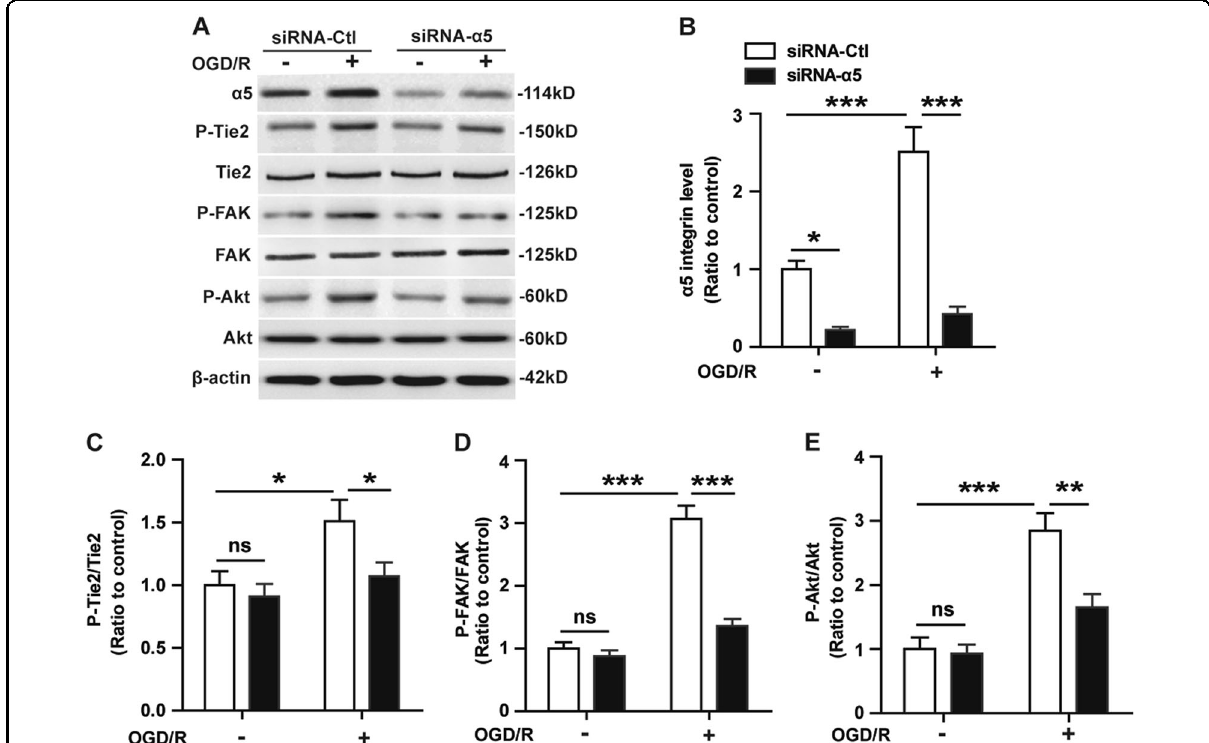
Fig. 3 Knockdown of α 5 integrin attenuates Tie2 activation in BECs induced by OGD/R. BECs were transfected with the negative control siRNA (siRNA-Ctl) or α 5 integrin-speci fi c siRNA (siRNA- α 5) for 48 h and then subjected to either 4 h of OGD followed by 48 h of restoration or NO-OGD/R at 37 °C. a Cell lysate protein levels were analyzed by western blotting using antibodies speci fi c to integrin α 5 and total or phosphorylated forms of Tie2, FAK, and Akt. b – e . Bar graphs show the quantitative analyses of western blots as ratios of integrin α 5/ β -actin ( b ), phosphorylated Tie2/total Tie2 ( c ), phosphorylated FAK/total FAK ( d ), and phosphorylated Akt/total Akt ( e ). The NO-OGD/R siRNA-Ctl-treated cells served as the control. Data represent the mean ± SEM and were analyzed by two-way ANOVA ( n = 5 ). Note that OGD/R signi fi cantly increased the levels of Tie2, FAK, and Akt phosphorylation on siRNA-Ctl-treated BECs relative to the NO-OGD/R siRNA-Ctl-treated controls, but this effect was signi fi cantly reduced by diminishing the levels of integrin α 5 in the BECs. * P < 0.05, ** P < 0.01, *** P < 0.001; ns, not signi fi